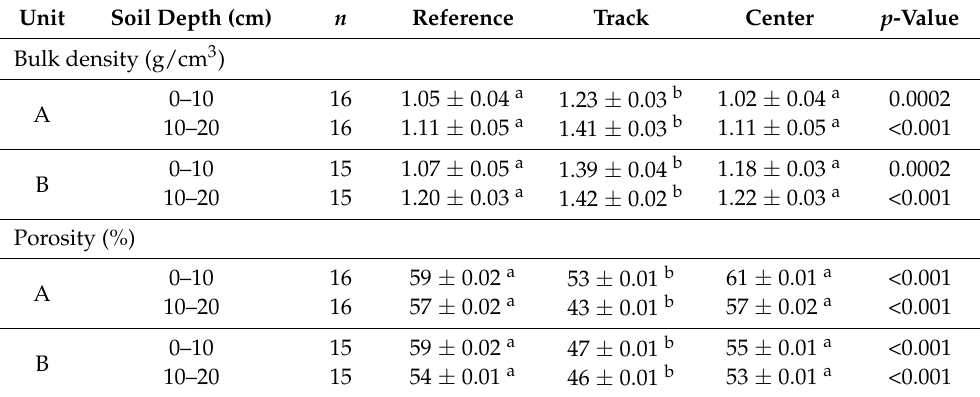
Table 2. Mean bulk density and porosity calculated at reference, track, and center locations in the harvester